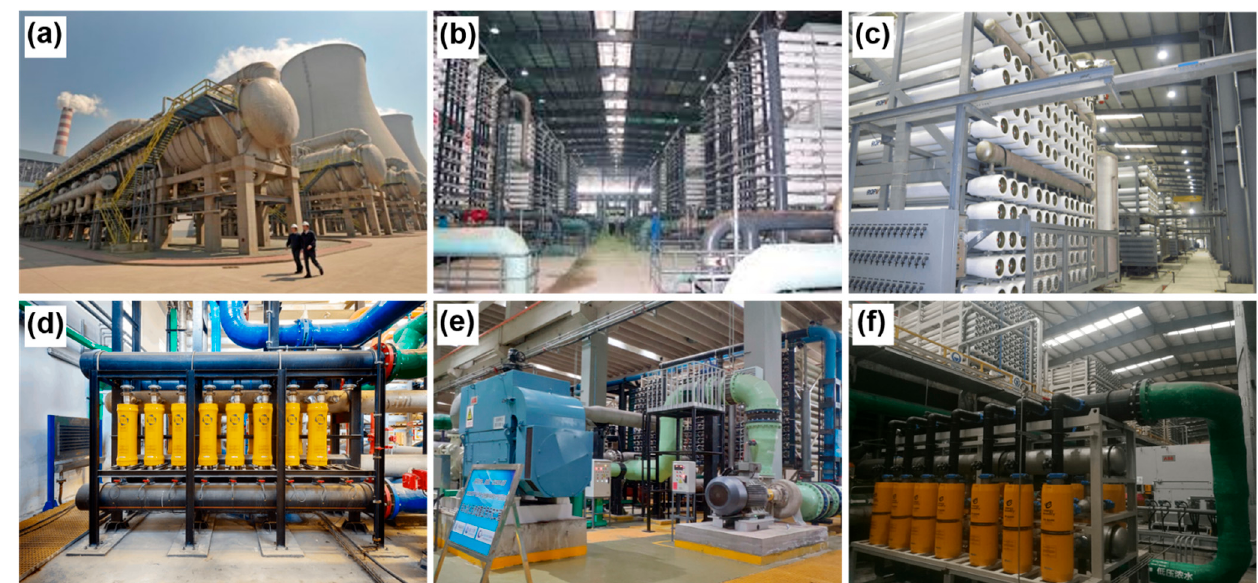
Figure 5. Seawater desalination projects with the capacity of >50,000 m 3 /d in China. ( a ) Beijiang Power Plant MED project, Tianjin (200,000 m 3 /d). ( b ) Dagang New Spring SWRO project, Tianjin (100,000 m 3 /d). ( c ) Caofeidian SWRO project, Tangshan (50,000 m 3 /d) . ( d ) Befesa SWRO project, Qingdao (100,000 m 3 /d). ( e ) Dongjiakou SWRO project, Qingdao (100,000 m 3 /d). ( f ) Zhejiang Petroleum SWRO/MED project, Zhoushan (180,000 m 3 /d).